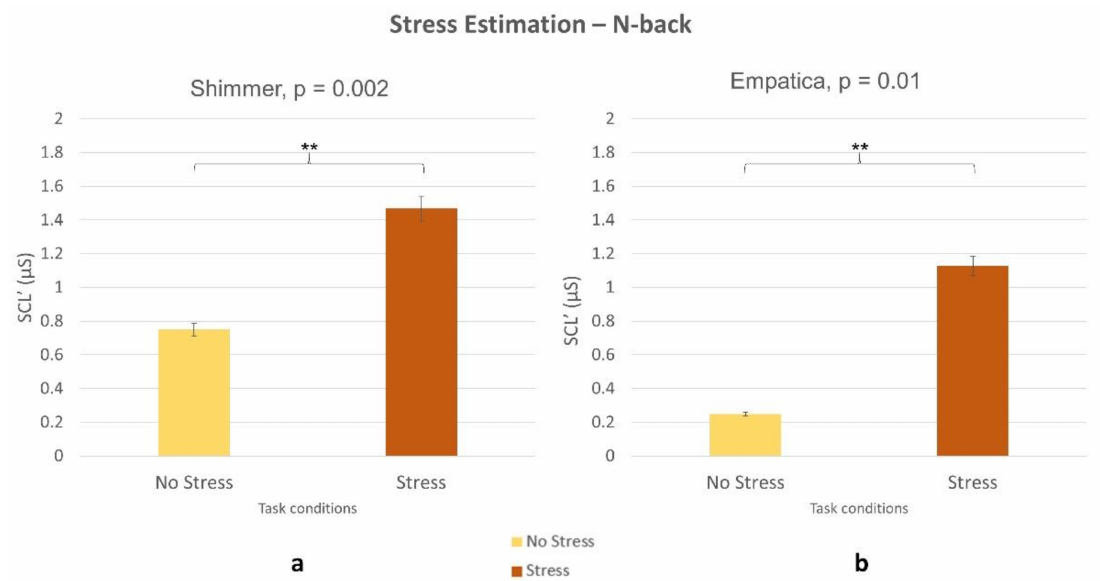
Figure 13. Increased SCL’ in stress vs. no stress condition during NB task. Statistical analysis revealed significant difference between the conditions for both ( a ) laboratory equipment ( p = 0.002) and ( b ) wearable device ( p = 0.1).